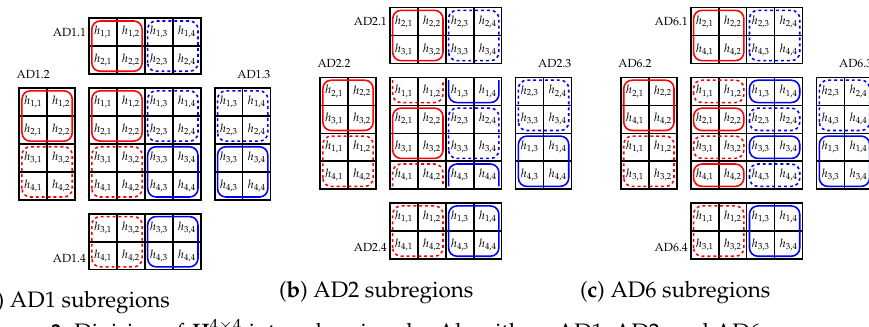
Figure 3. Division of H 4 × 4 into subregions by Algorithms AD1, AD2, and